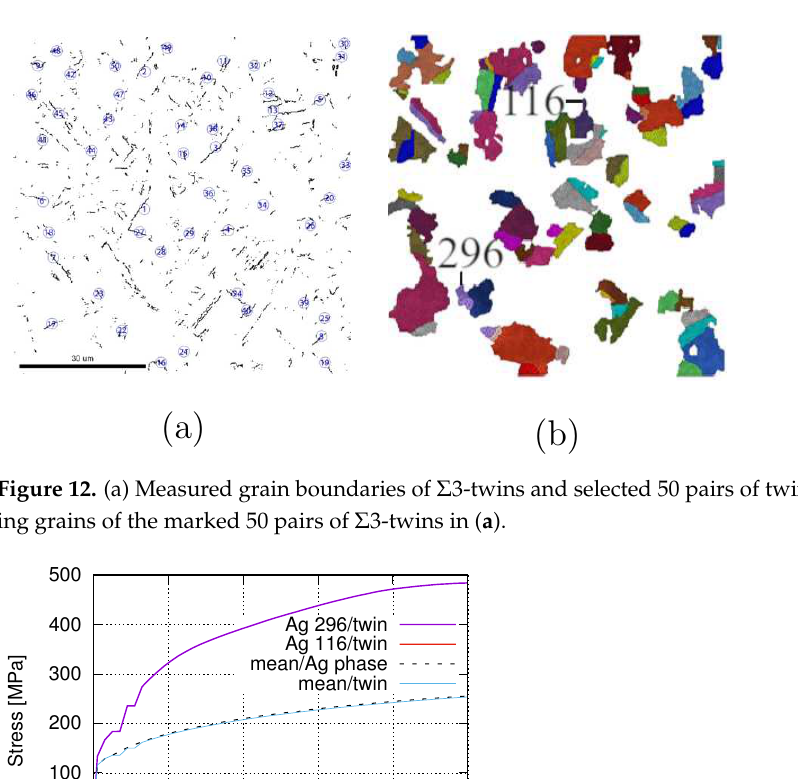
Figure 13. The stress flow behavior according to the global strain among the 50 pairs of Σ 3-twins in Figure